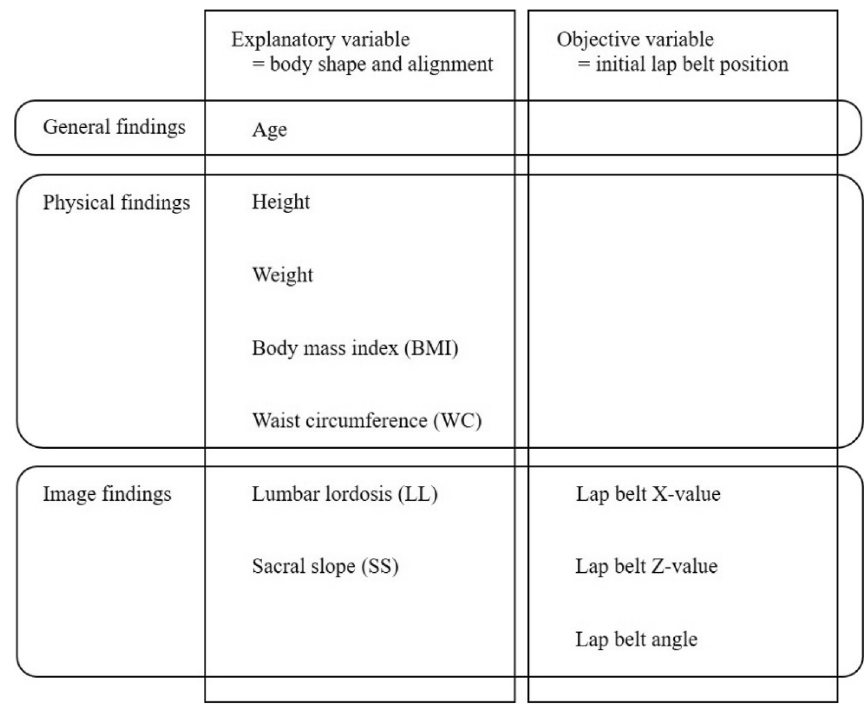
Figure 4. Explanatory variables and objective variables. Age and physical characteristics of height, weight, Body mass index (BMI) 10 , and Waist circumference (WC) were used as explanatory variables. Among the X-ray findings, Lumbar lordosis (LL) and Sacral slope (SS) were used as explanatory variables, while the X-value of the lap belt, the Z-value of the lap belt, and lap belt angle were used as objective variables.